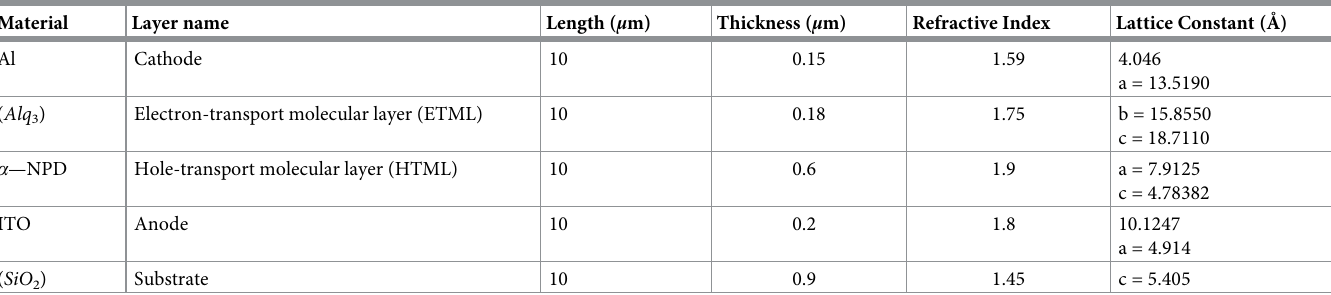
Table 1. Physical properties of several layers of OLEDs [29].